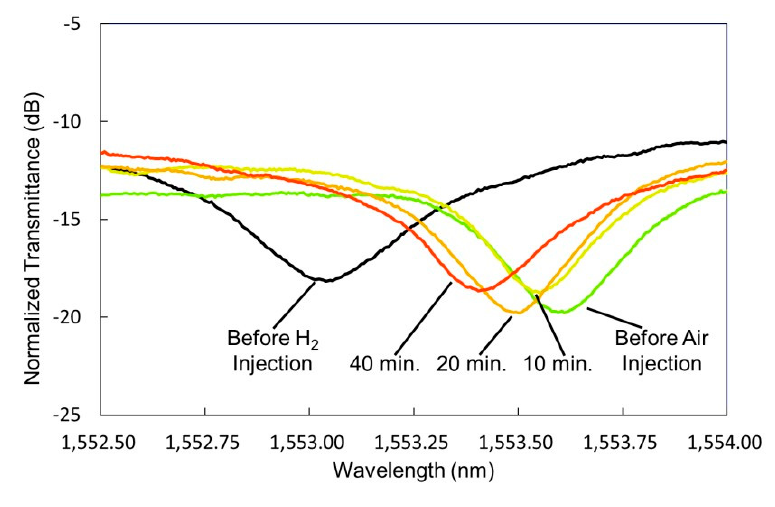
Figure 4. The sensor response to air after the exposure to pure